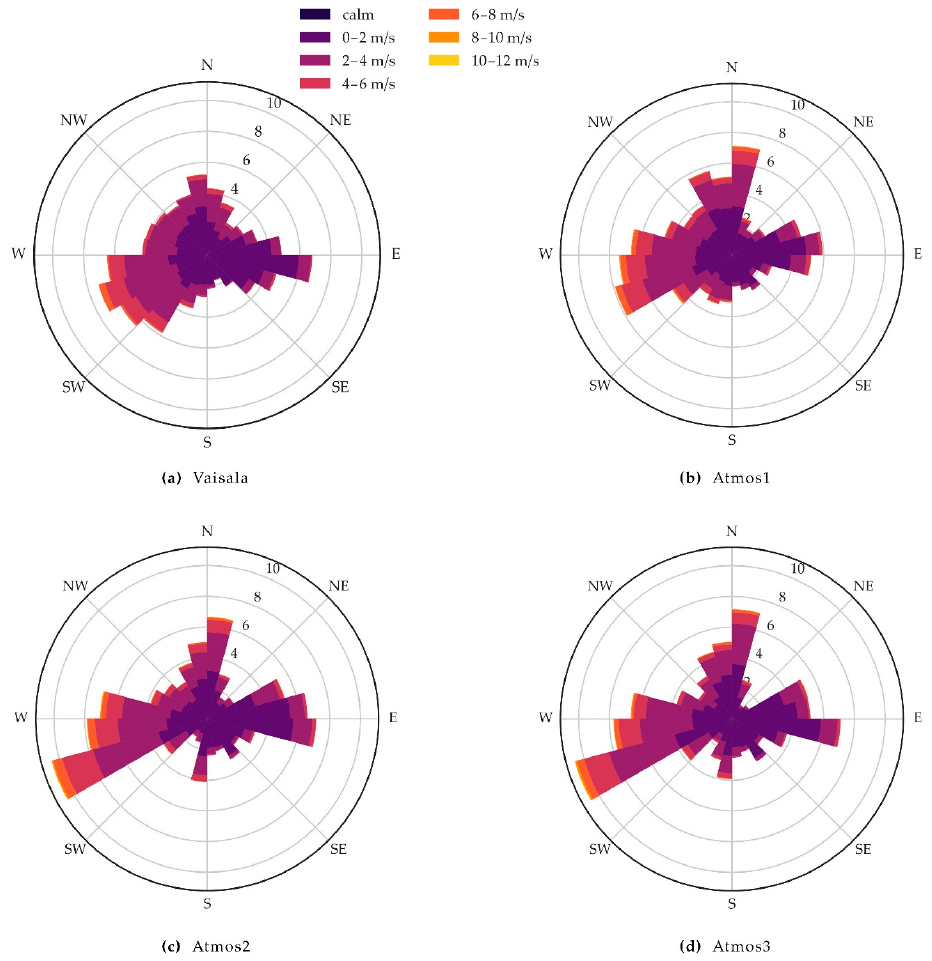
Figure 10. Wind roses showing the frequency of observed wind direction at a 10 min interval measured by ( a ) the Vaisala reference station. ( b – d ) the three ATMOS41 weather stations, for the period from 23 April to 5 July 2020.